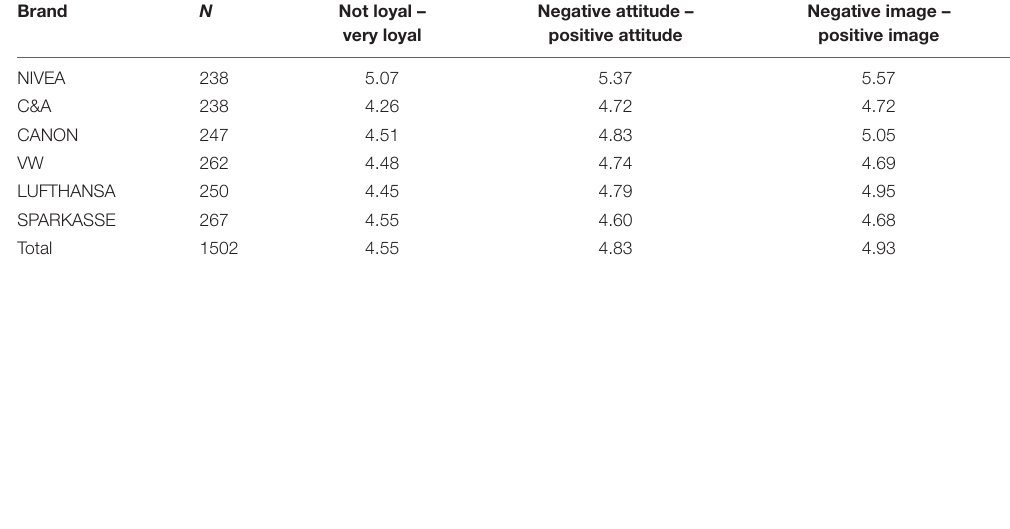
Total (B) Brand equities before the sales encounter (7-point Likert scale). Brand